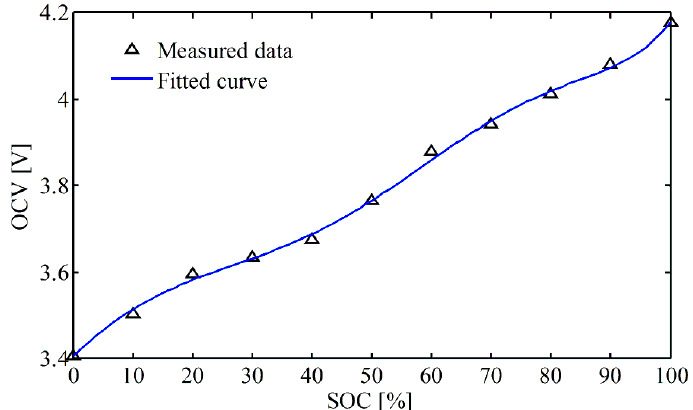
Figure 2. Measured and fitted open circuit voltage ( OCV ) vs. state of charge ( SOC